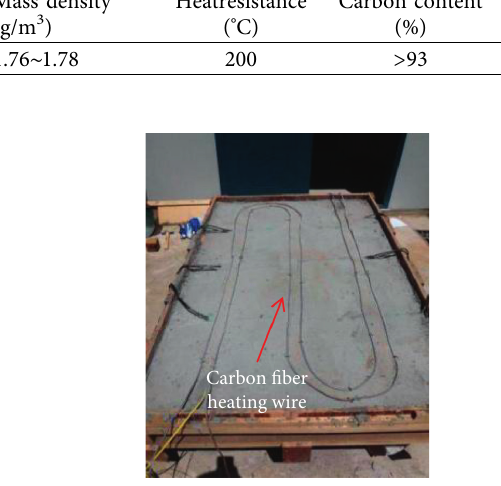
Figure 4: Arrangement of the carbon fiber heating